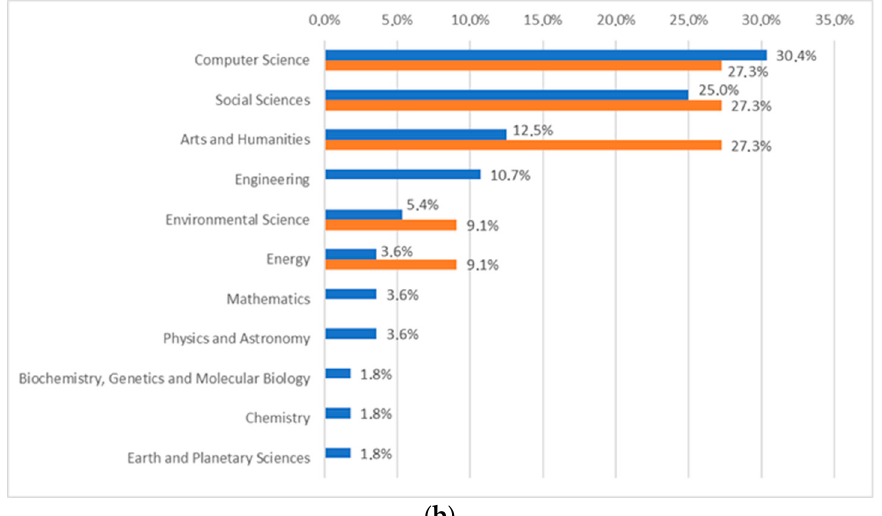
Figure 3. Subjects of the publications relating “augmented reality” with ( a ) “cultural heritage” (in blue) and “dissemination” (in orange); ( b ) “architectural heritage” (in blue) and “dissemination” (in orange).